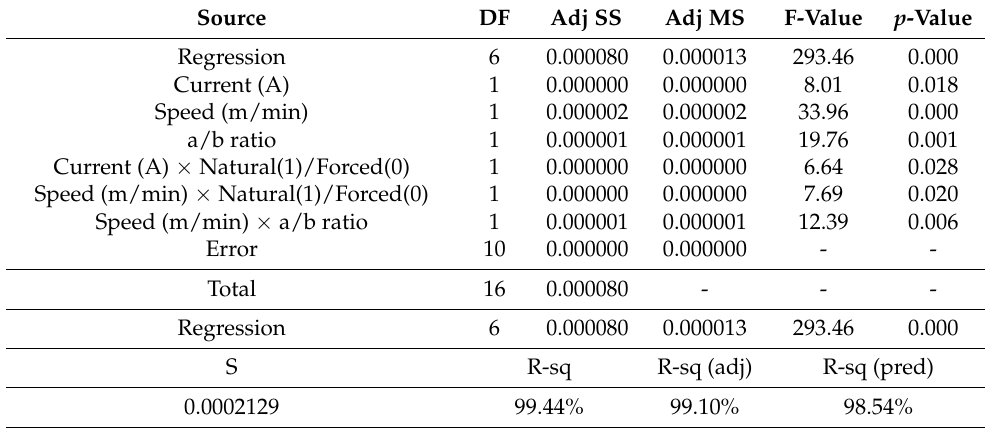
Figure 10. Range of residual stresses measured. With an increase in aspect ratio, the stress bands widen but shift from tensile to compressive sides, which is a good indication. Compressive residual stress helps in delaying crack propagation. However, the maximum value of residual stress decides the overall structural integrity. The precise and collective effect of the experimental conditions on the maximum residual stress is assessed through the ANOVA in Table 7. Table 7. ANOVA: Residual Stress (stepwise